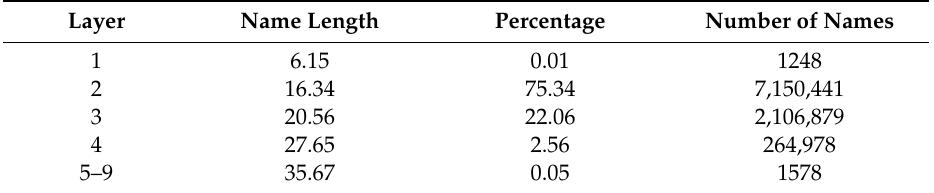
Table 4. Ten-meter prefix table.